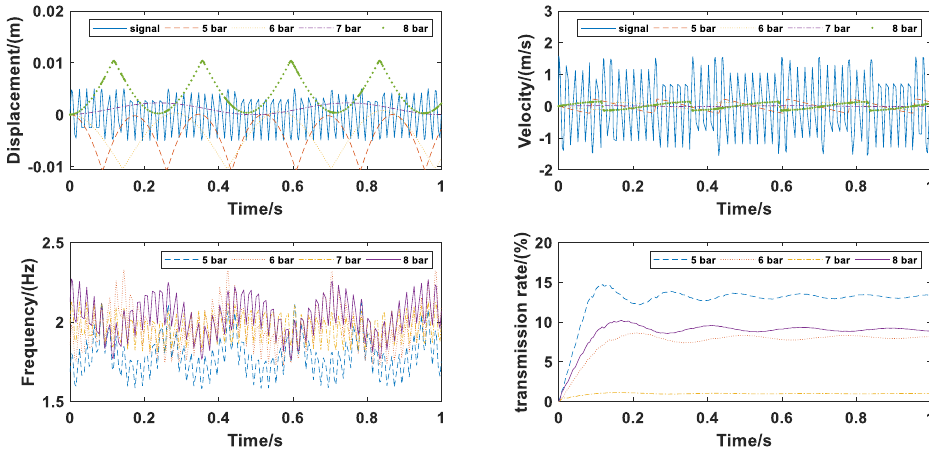
Figure 6. Simulation results under 50 Hz, with 5 mm amplitude vibration.